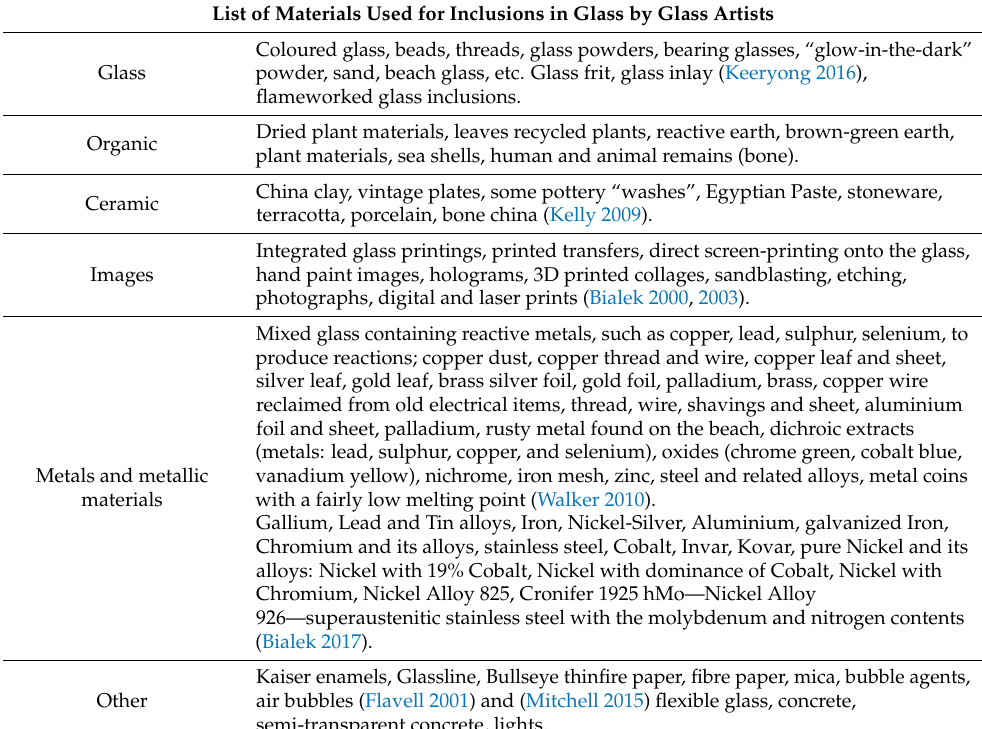
Table 1. Classification of inclusions in